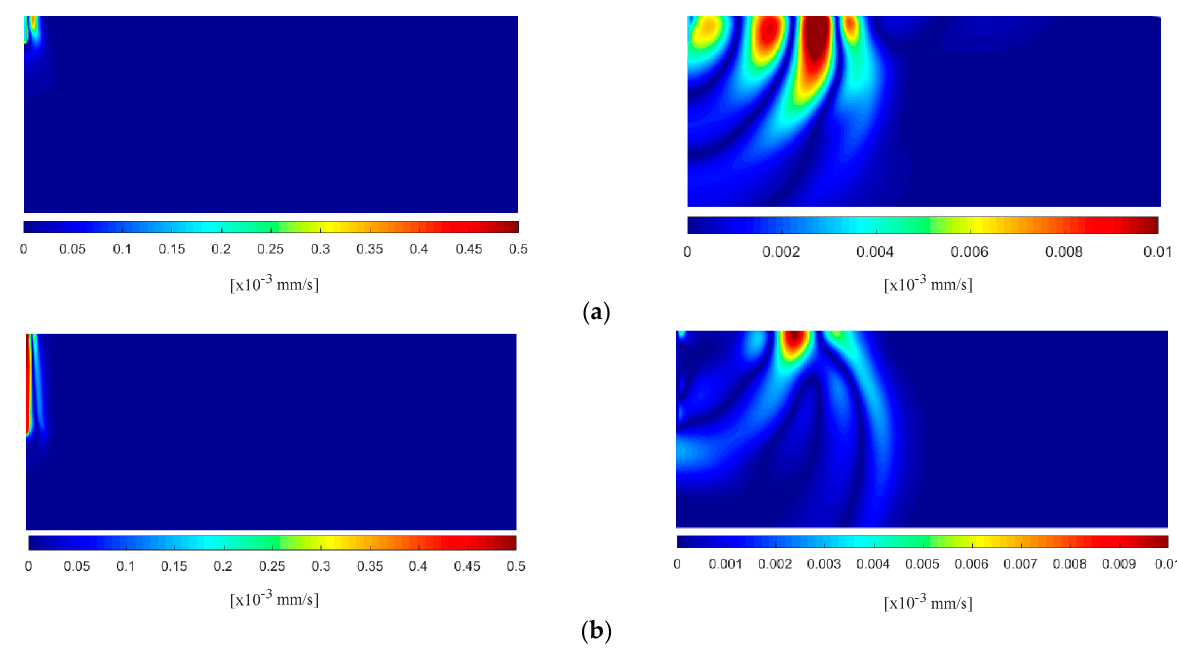
Figure 12. The norm of the particle velocity in a homogeneous half space at t = 40 ms (left) and t = 125 ms (right) due to impact pile driving for pile embedment depths of ( a ) 2.5 m; ( b ) 10 m (units: 10 3 mm/s).